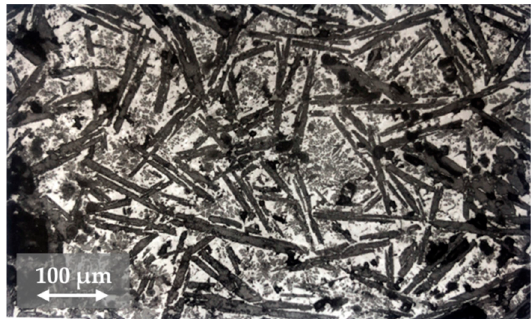
Figure 6. Needles of tricalcium silicate and globular particles of dicalcium silicate, RO-phase, and calcium ferrites in the slag sample collected after minute 24 of oxygen blowing, in the melting process D, sample D24.